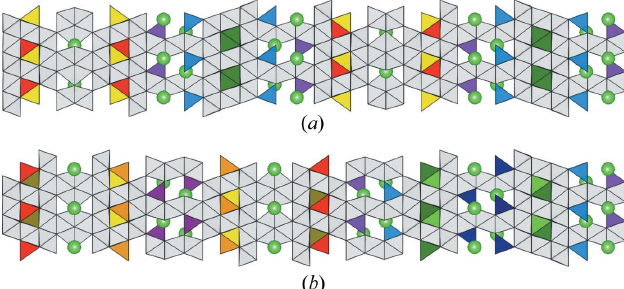
Figure 12 ( a ) Tetrahedral sites for the (17) 2 hexaferrite. Each colour refers to one of five groups of symmetry-related tetrahedra, with all other polyhedra shown in white. We can see that two groups lie in RST layers (Fe05 shown in red and Fe06 in yellow), two groups lie in T blocks (Fe07 shown in blue and Fe0A in purple) and the Fe (green) group lies in a TST layer. ( b ) Tetrahedral sites for the (34) 3 hexaferrite. The unit cell contains a threefold repeat of the sequence shown, with subsequent repeats translated in-plane by (2/3, 1/3). Each colour refers to one of ten groups of symmetry-related tetrahedra, with all other polyhedra shown in white. We can see that four groups lie in RST layers (Fe08 shown in red, Fe0B in gold, Fe0I in orange and Fe0S in yellow), four groups lie in T blocks (Fe0E shown in dark blue, Fe0J in light blue, Fe0O in dark purple and Fe0Q in light purple) and two groups lie in TST layers (Fe1A shown in dark green and Fe1 in light